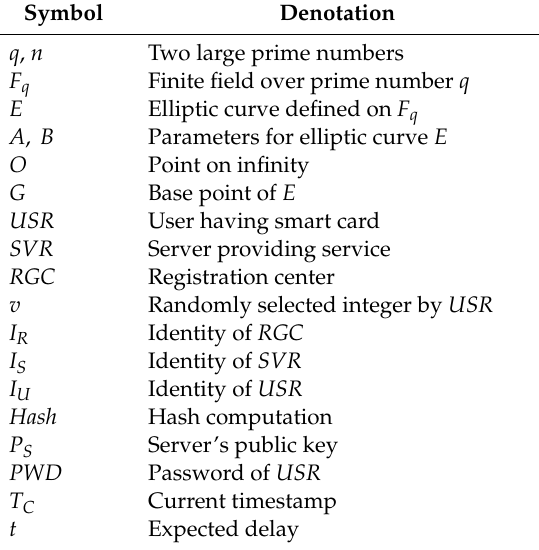
Table 2. Symbols and notations used in the proposed Elliptic Curve Signcryption based Security Protocol for Smart Cards